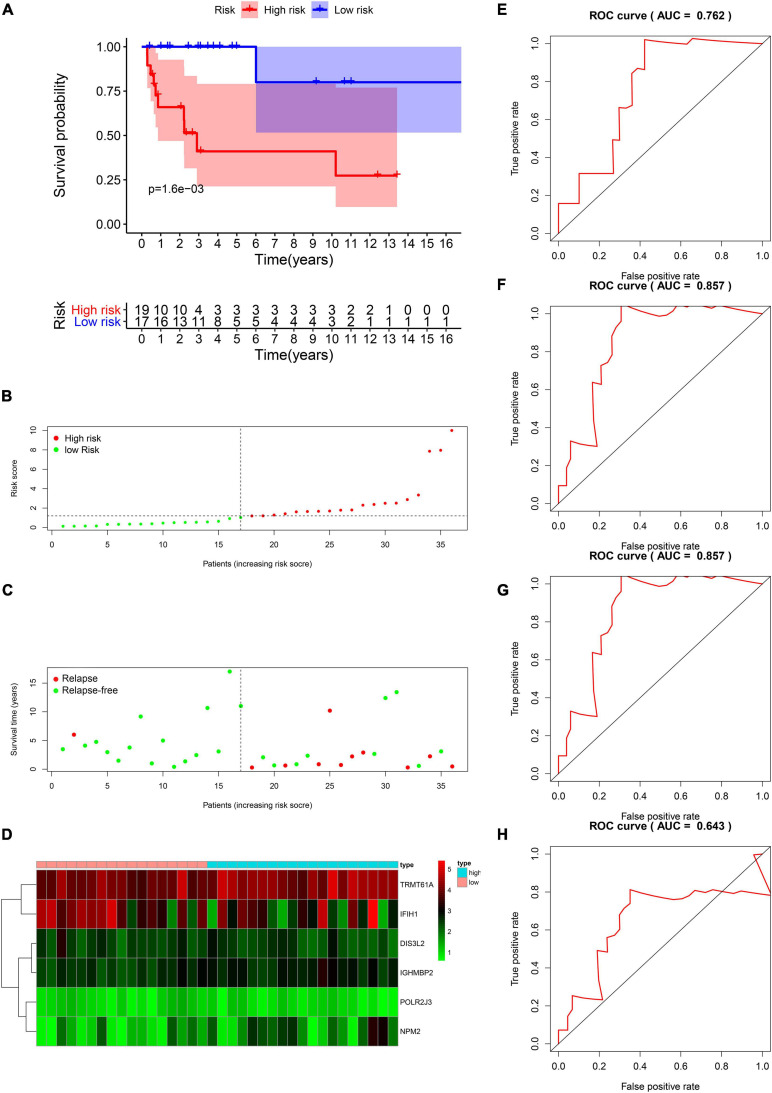
Validation of the prognostic value of the risk model in the test group. (A) Kaplan–Meier survival curve analysis of DFS in the high-risk and low-risk TGCT patients in the test group, marked as red line and blue line separately. (B–D) Risk score, distribution of survival status between the high-risk and low-risk groups and expression heat maps of six RBPs. (E–H) Time-dependent ROC curve analyses was conducted and AUC values were calculated for 1-, 3-, 5-, and 10-year DFS in the TGCT test cohort. TGCT, Testicular germ cell tumors; DFS, disease-free survival; RBPs, RNA-binding proteins; TGCT, Testicular germ cell tumors; ROC, Receiver operating characteristic curve; AUC, the area under the ROC curve; High, high-risk group; Low, low-risk group.